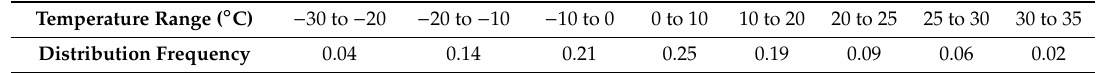
Table 13. Frequency data for air temperature distribution in